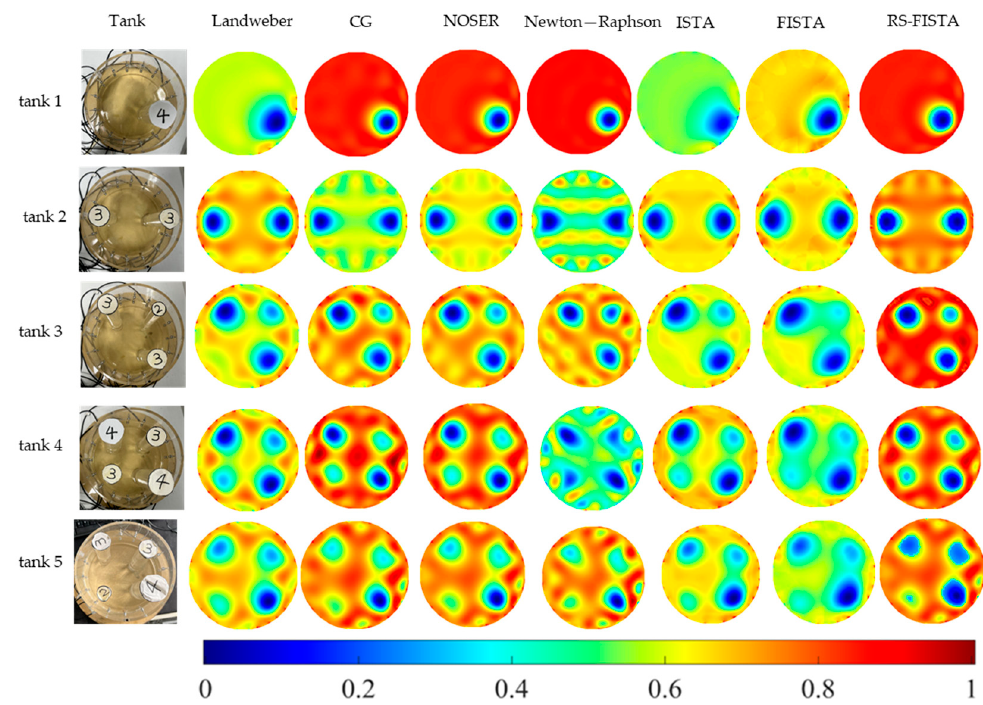
Figure 4. Imaging results of bucket experiment with different algorithms (the numbers 2–4 represent the diameter of the inclusions). Table 2. Experimental evaluation metrics for imaging results of 7 different